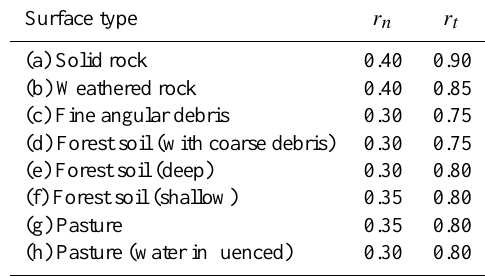
Table 2. Coefficients of restitution ( r n = normal, r t = tangential) used in the 2-D simulation series Steg and Bad